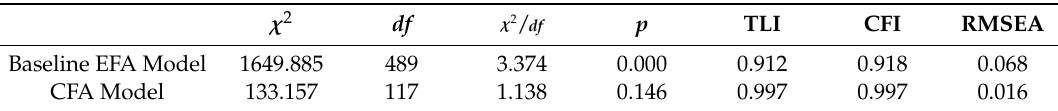
Table 4. Goodness-of-fit indices for the baseline EFA model and the confirmatory factor analysis (CFA) model for the PIS-HSP